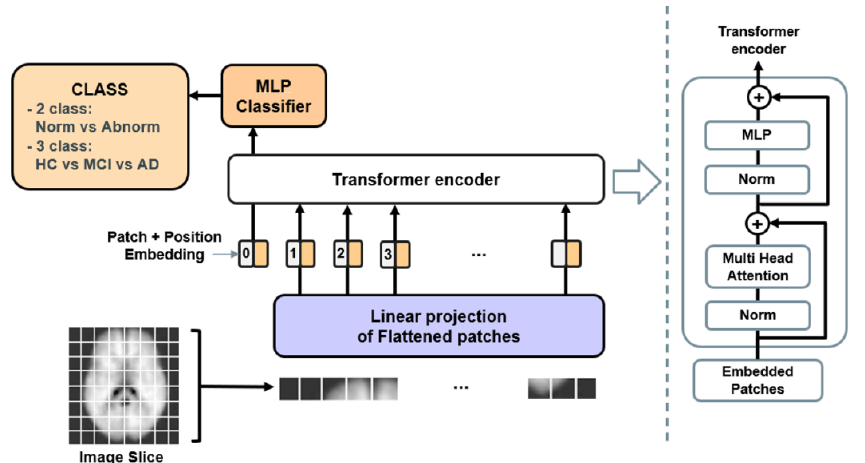
Figure 3. Vision Transformer model architecture.